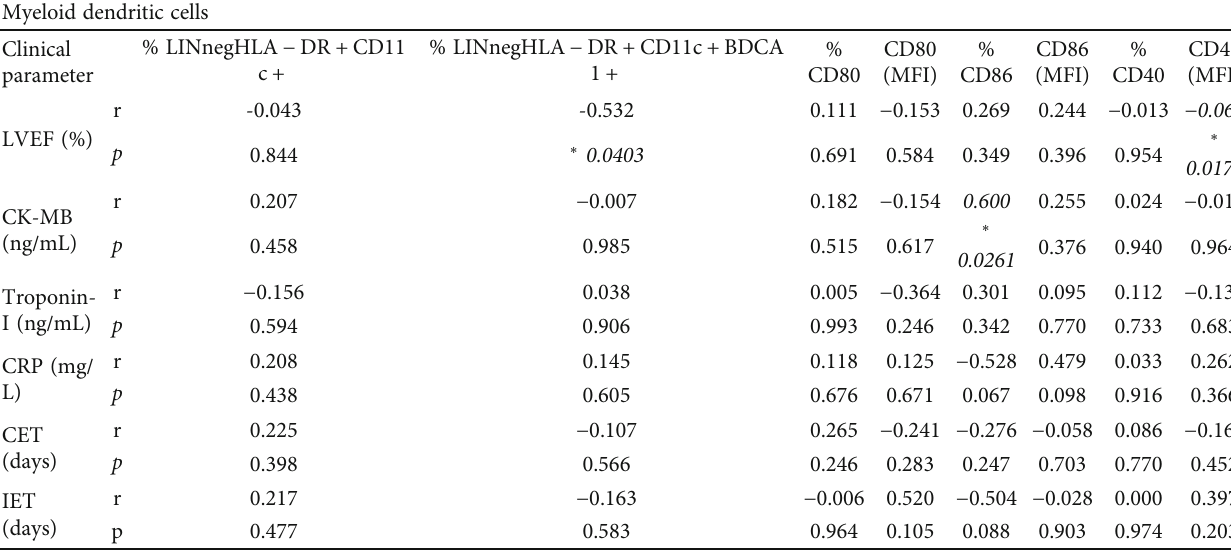
Table 2: Correlation between phenotypic characteristics of myeloid dendritic cells (mDCs) with di ff erent clinical parameters. Myeloid dendritic cells Clinical parameter